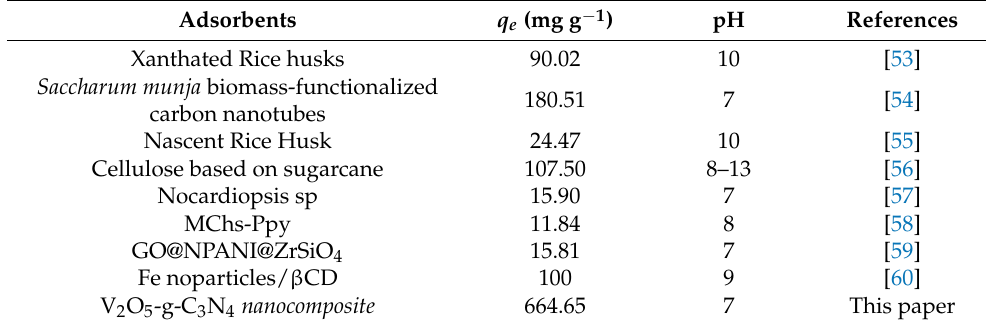
Table 2. Observation of CV adsorption capacities of the V 2 O 5 -g-C 3 N 4 nanocomposite with the different nanomaterials’ adsorbents.